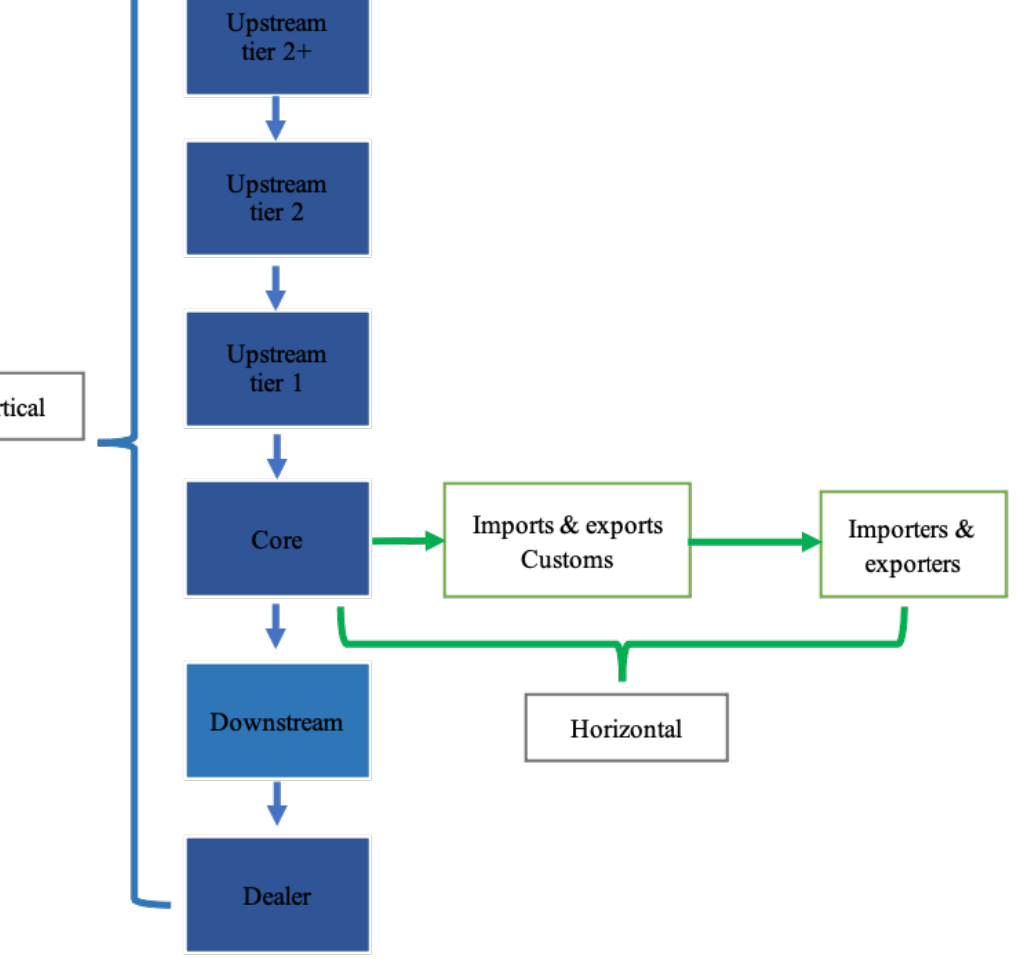
Figure 1. The scope of SCF standing position at “Core”.